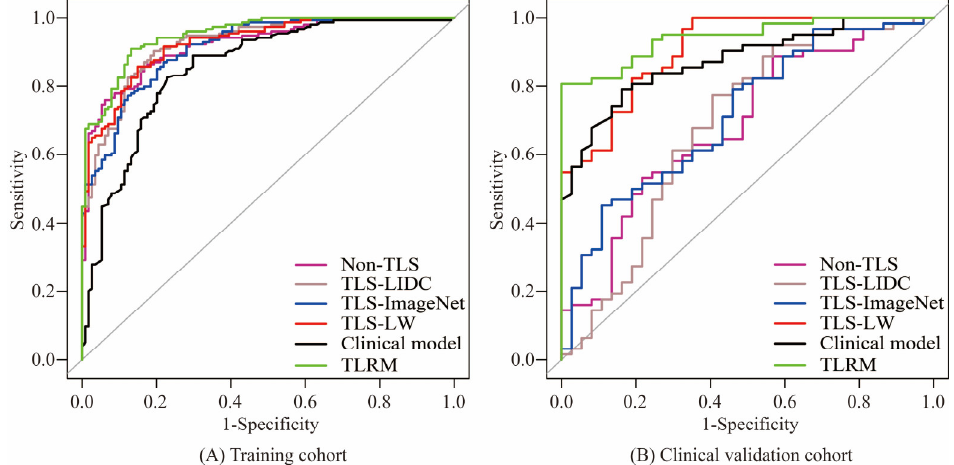
Figure 7. The receiver operating characteristic of Non-TLS, TLS-LIDC, TLS-ImageNet, clinical model, TLS-LW and TLRM in the training cohort ( A ) and clinical validation cohort ( B ). Note: Non-TLS, nontransfer learning signature; TLS-LIDC, transfer learning signature based on LIDC; TLS-ImageNet, transfer learning signature based on ImageNet; TLS-LW, transfer learning signature based on lung cancer WSI; TLRM, transfer learning radiomics model; AUC, area under the curve.